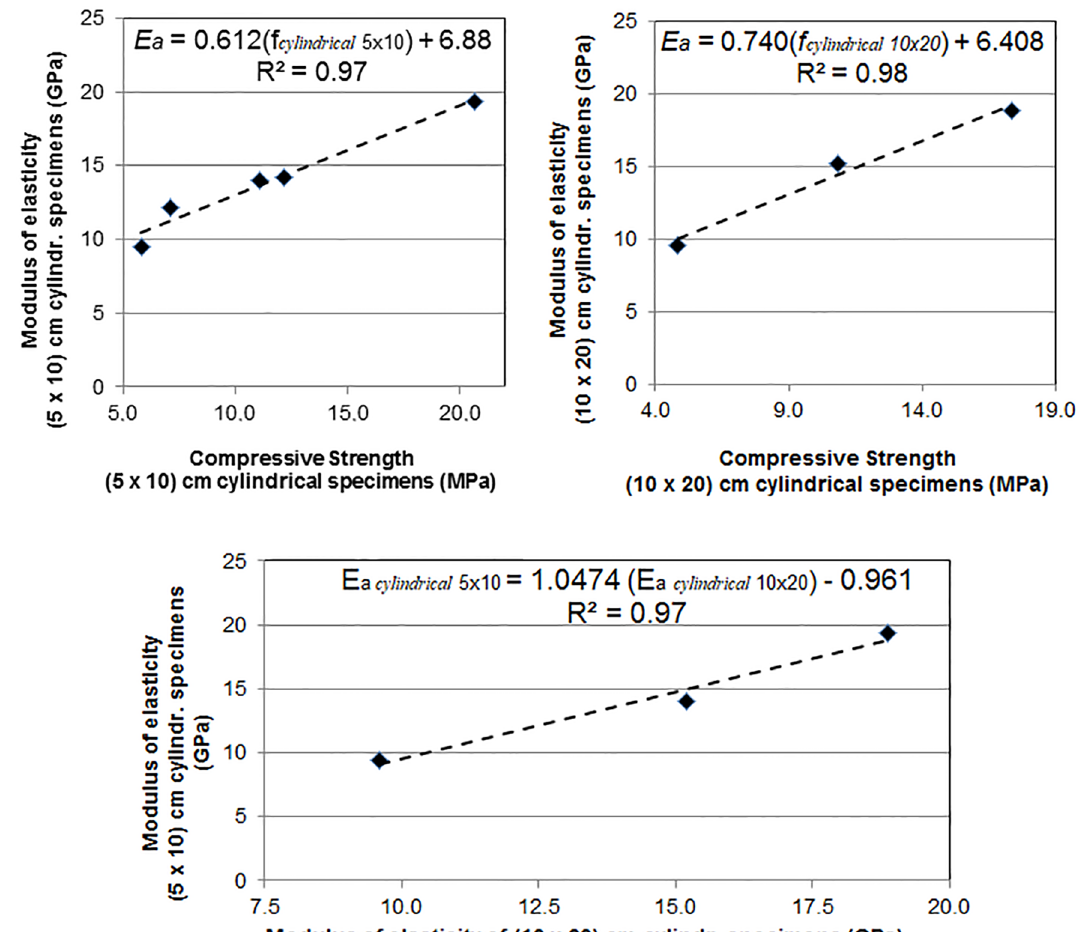
Figure 5. Correlations between compressive strength and modulus of elasticity of cylindrical specimens of different